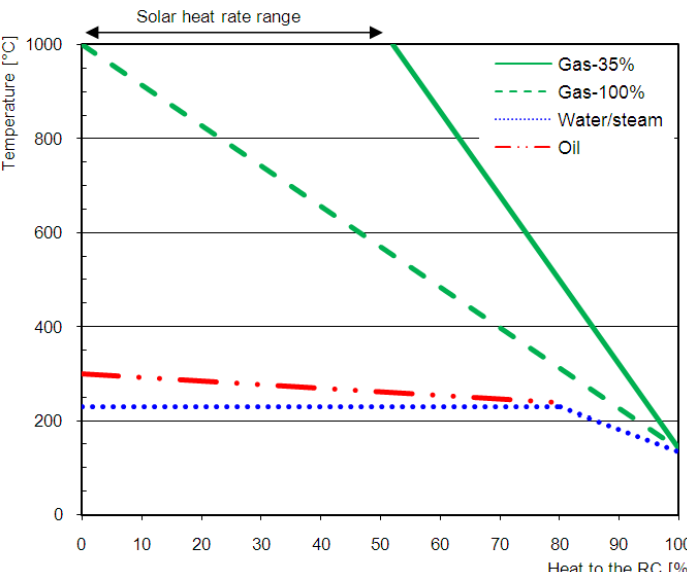
Figure 3. Temperature-Heat